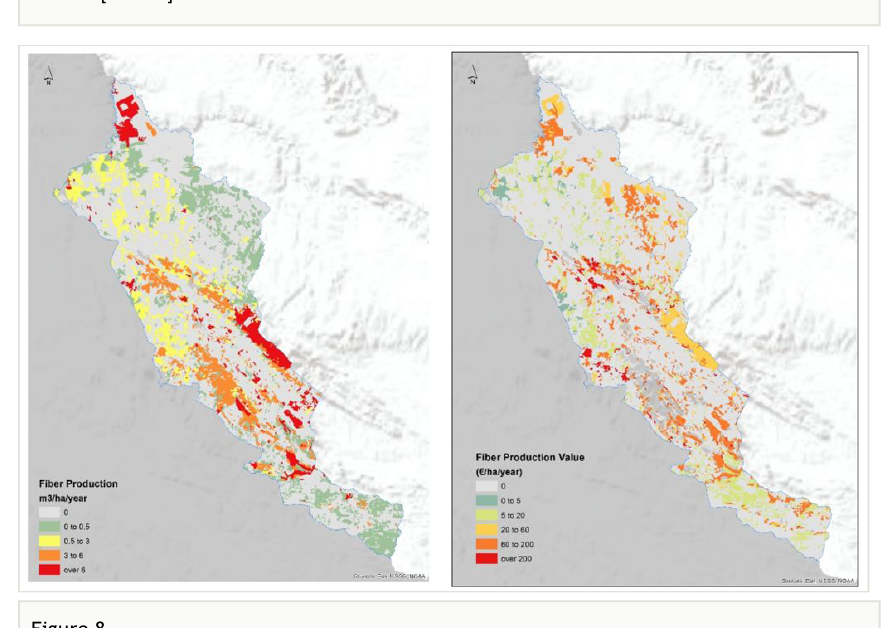
Figure 8. Spatial quanti fi cation (left) and economic valuation (right) of Fibre Production service [ 1.1.1.2 ] within